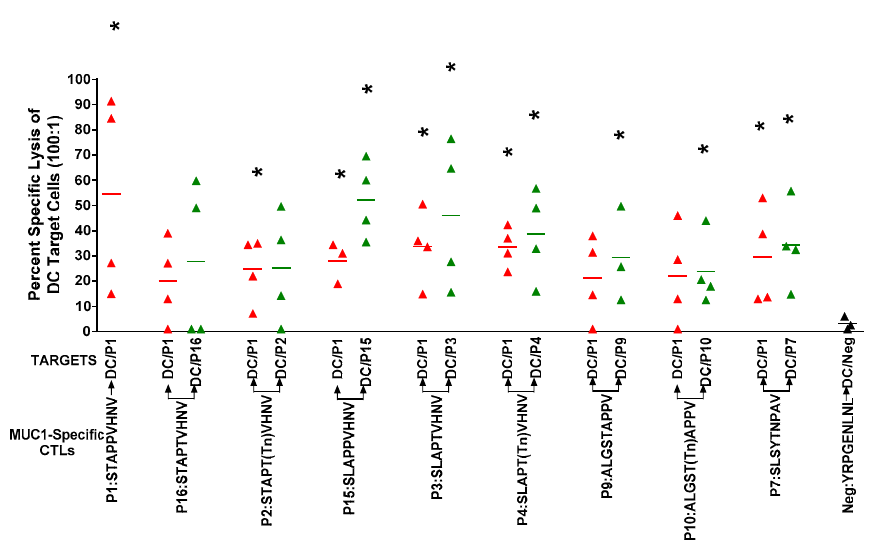
Figure 4. CTLs were lytic to DCs pulsed with the immunizing peptide and showed cross-reactive lytic activity to the native P1 peptide STAPPVHNV. Autologous DCs pulsed with various MUC1 peptides (50 μ g/mL) and PADRE peptide (10 μ g/mL) were used as targets. Effector:target ratio was 100:1 and spontaneous release was less than 15% of complete lysis. * p < 0.05 (Student’s t ‐ test) compared to the negative peptide. ELISpot analysis of CD8 + T cells generated to MUC1 peptides optimized in the second position to